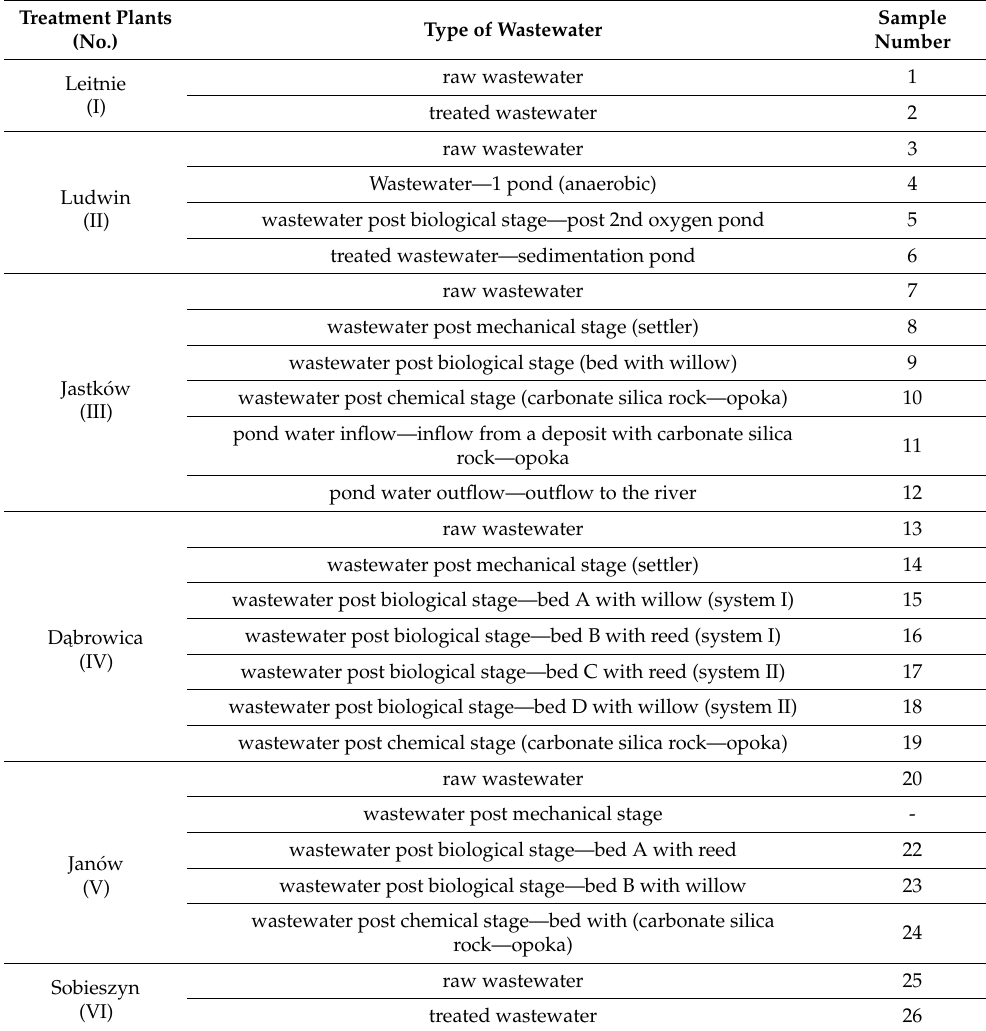
Table 2. Types of sewage samples taken for analyses from individual treatment plants and numbered; “-” not